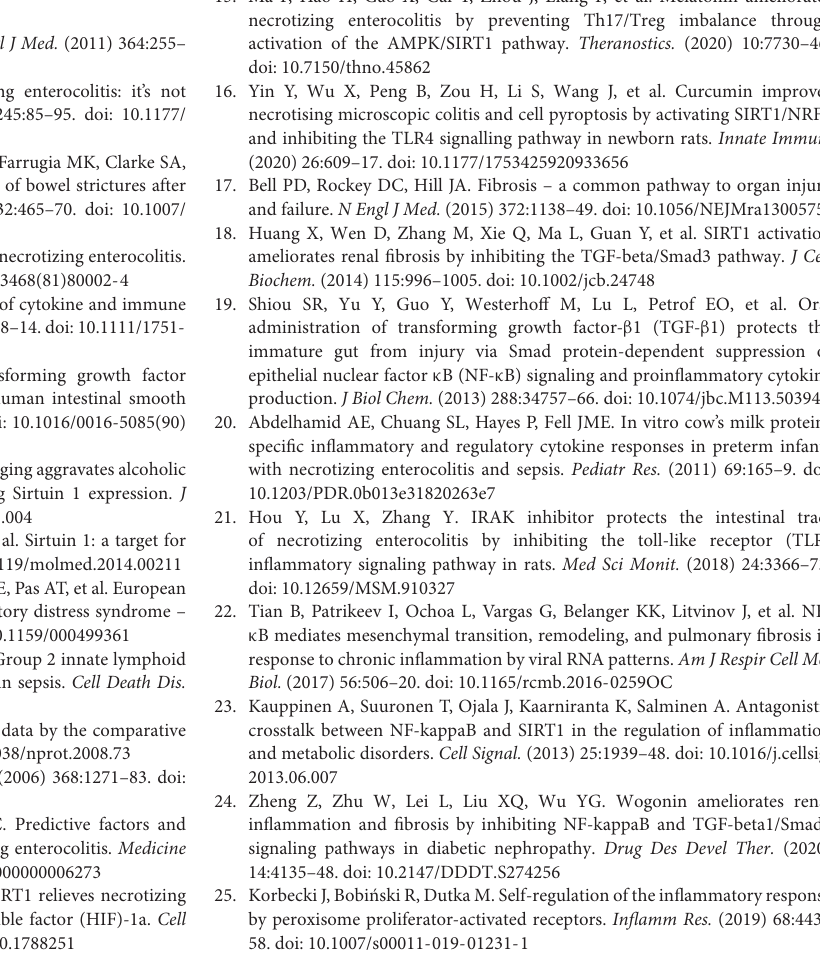
Supplementary Figure 1 | The expression of Sirtuin1 or Silent mating–type information regulation 2 homolog-1 (SIRT1) and transforming growth factor- β 1 (TGF- β 1) in post-necrotizing enterocolitis (NEC) intestinal stricture tissues (more